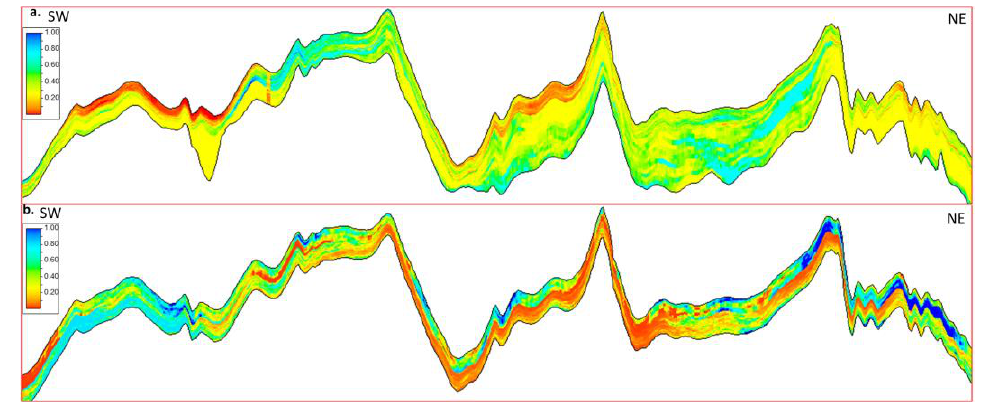
Figure 14. SW – NE intersections of shale volume model of Unit 4 ( a ) and Unit 5 ( b ). The shale volume